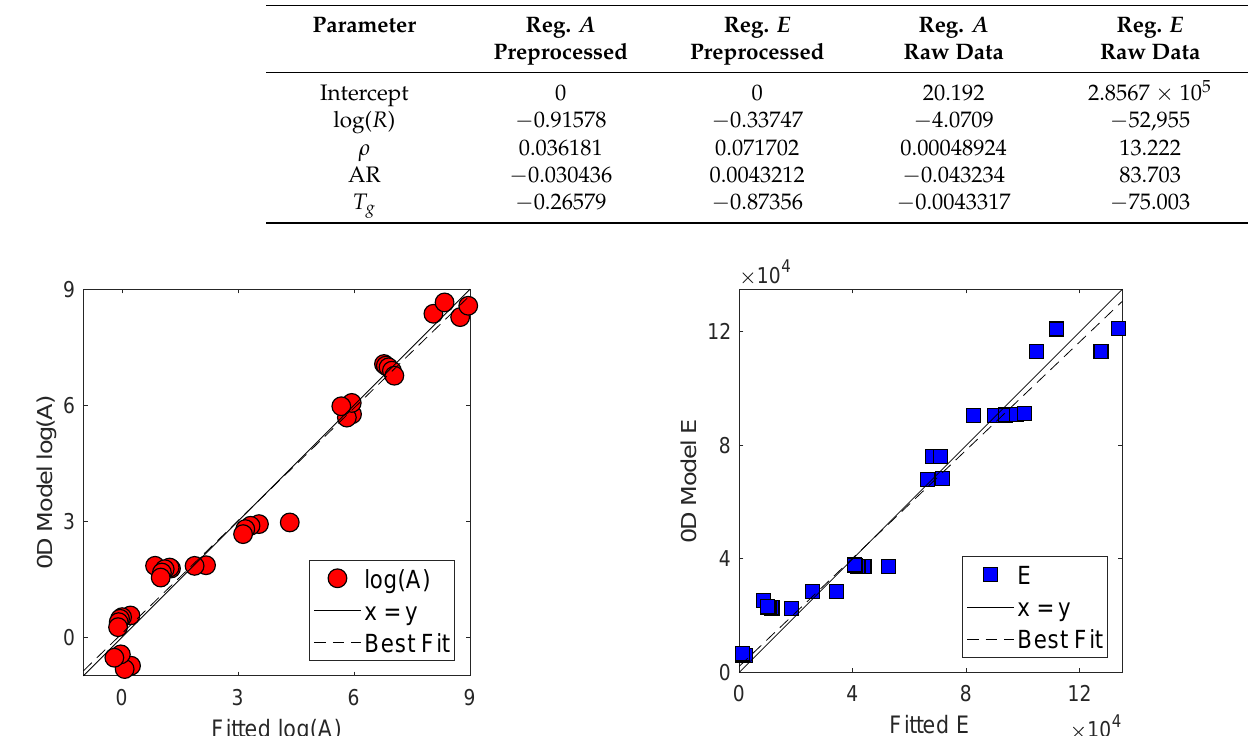
Table 5. Regression vectors for A (model 2) and E (model 2).